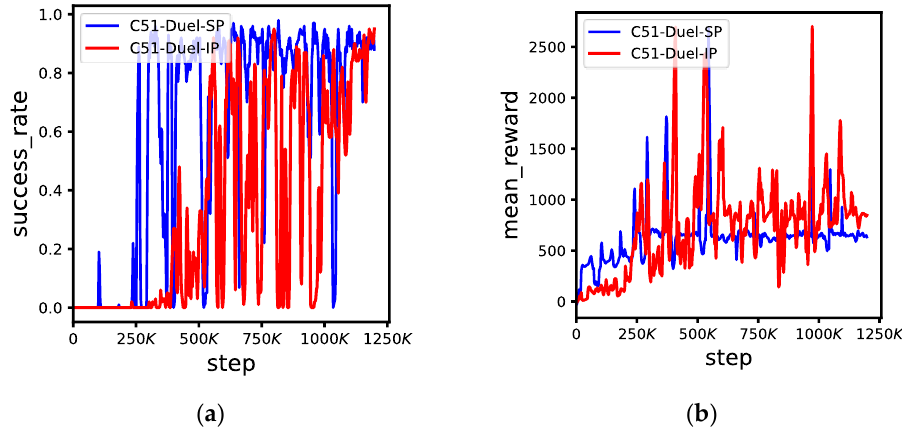
Figure 6. Comparison of independent policies and shared policies in scenario 1: ( a ) shows the suc- cess rate; ( b ) shows the mean reward in each episode. rate; ( b ) shows the mean reward in each